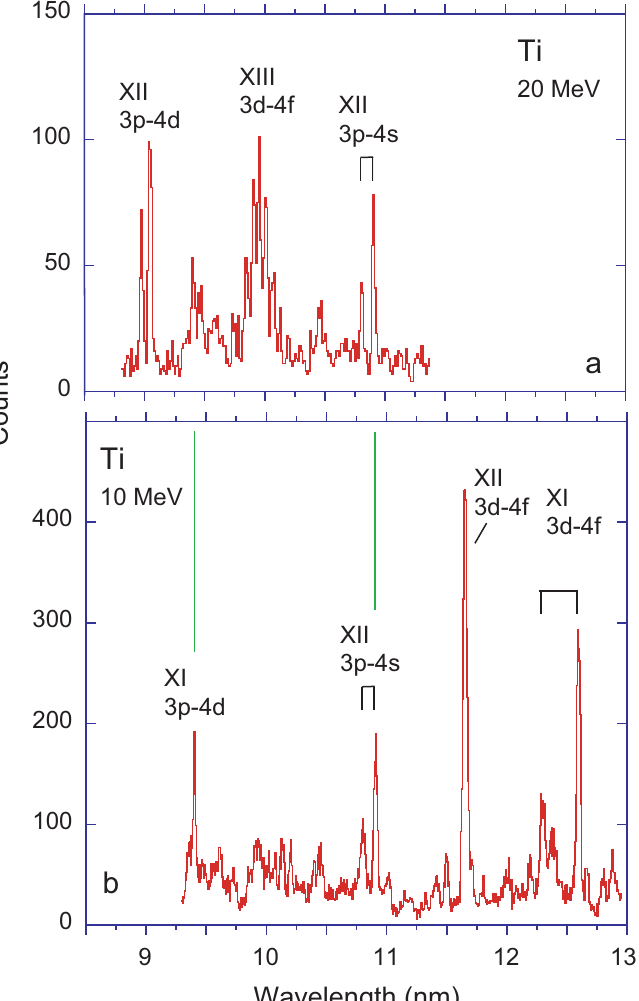
Figure 1. Beam–foil spectra of Ti observed at two ion beam energies ( a ) 20 MeV, ( b ) 10 MeV, line width (FWHM) 0.035 nm. The strongest lines are identified by the spectrum number and transition array. Many of the weak lines remain unidentified so